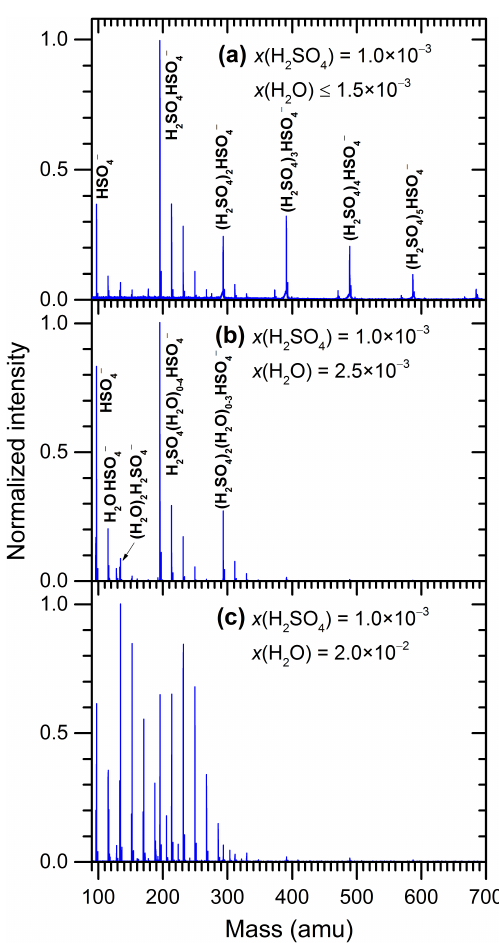
Figure 1. Negative ion mass spectra integrated in the electron- energy range 0–10eV. Panels (a) – (c) show a decreasing H 2 O mole fraction in the vapor coexpanding with constant H 2 SO 4 mole frac- tion in helium. See Fig. 2 for analysis of the spectrum (c)